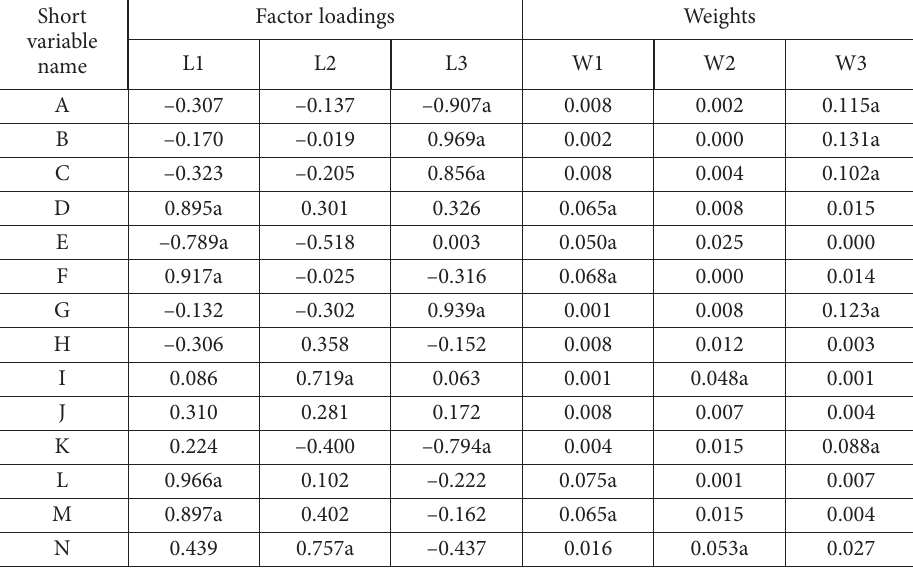
Table A2. The results of applying the first mathematical formula (source: authors’ calculation) Short